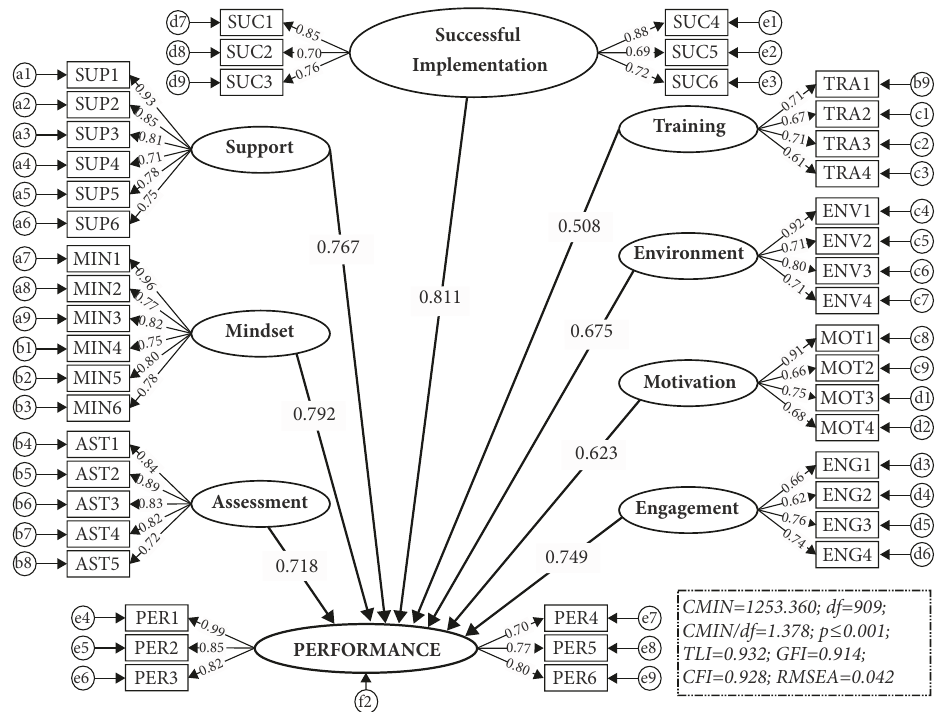
Figure 4: Standardized SEM model of sustainable performance of SMEs in